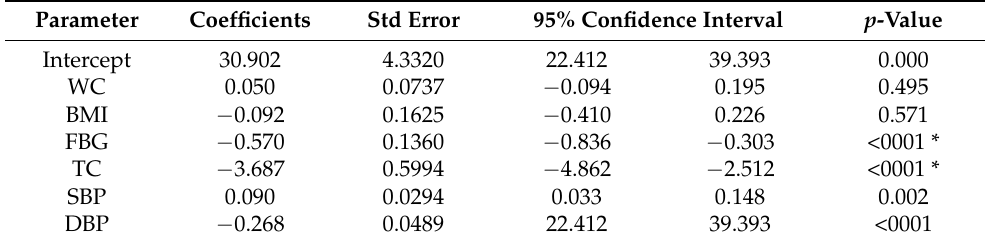
Table 7. Negative binomial regression between MVPA and